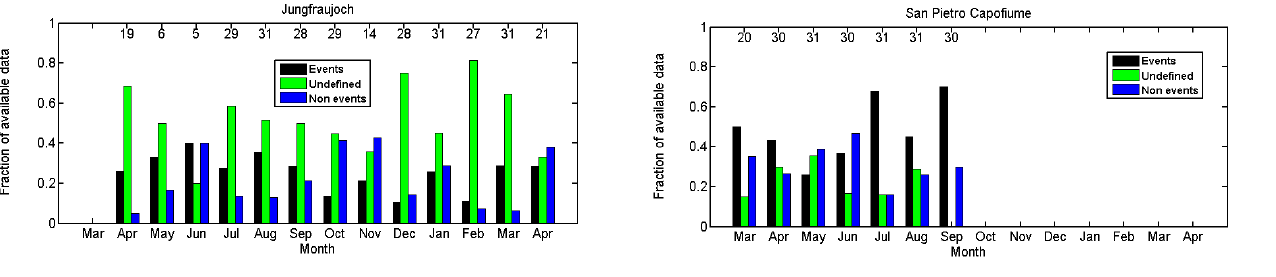
Fig. A9. The fraction of event, undefined and non-event days out of all analyzed days during each month in the year at Jungfraujoch, Switzerland, during April 2008–April 2009.